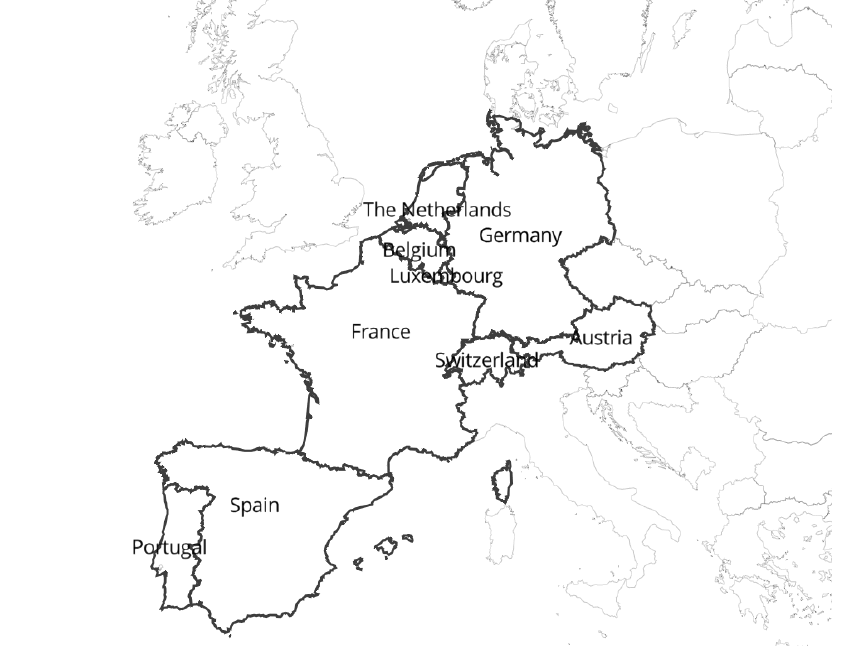
Figure 4. The European countries considered in the case study in Section